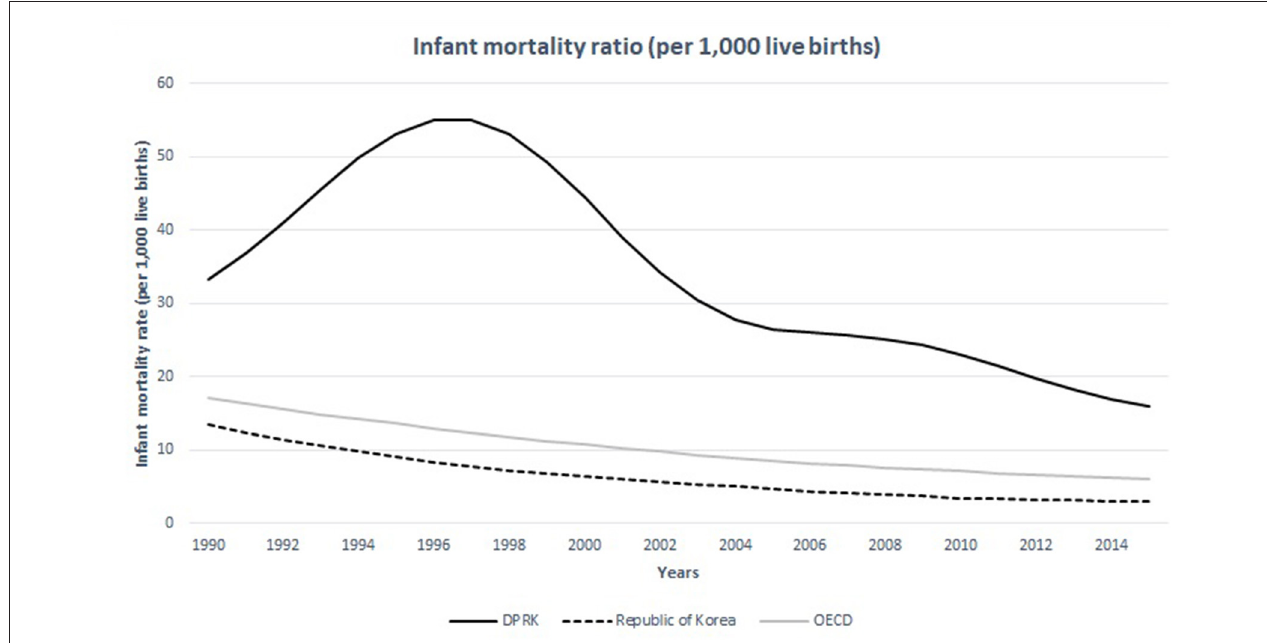
FIGURE 4 | Maternal mortality ratio of the DPRK in comparison with the Republic of Korea and the nations of OECD between 1990 and 2015. Source: WHO, UNICEF, UNFPA, World Bank Group, and the United Nations Population Division (13).